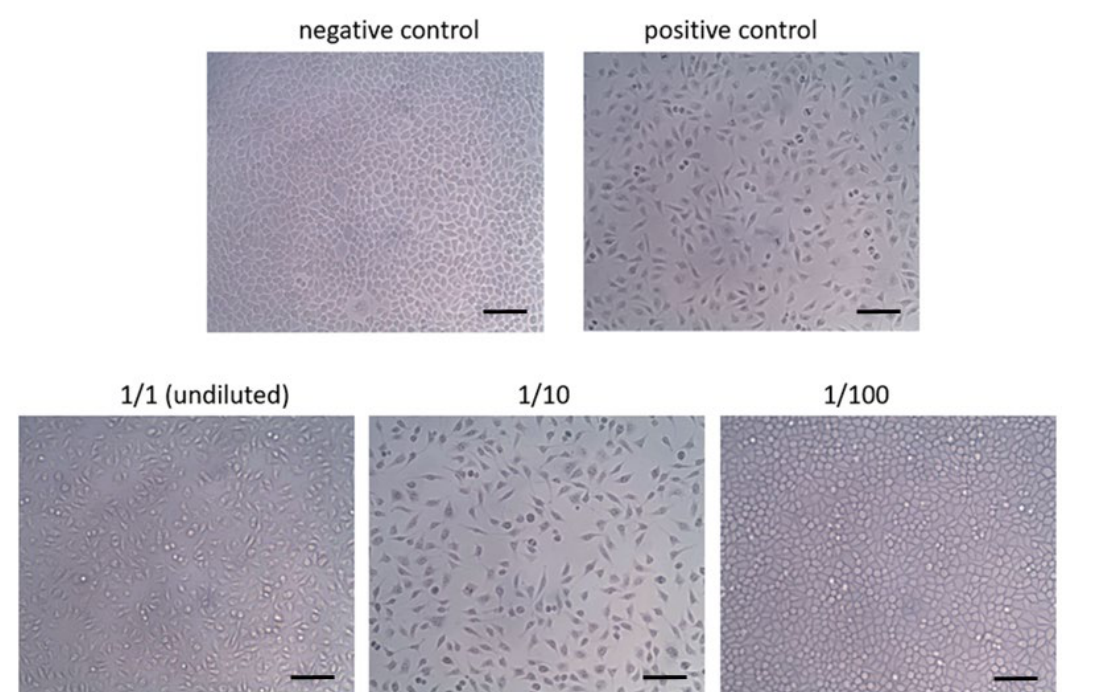
Figure 1. Cells treated with the tested solutions and controls (200×). Bars: 40.0 µm.